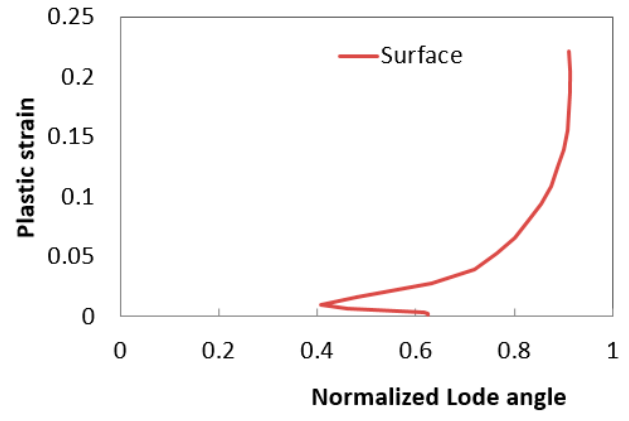
Figure 27. Lode angle for notched tensile test.